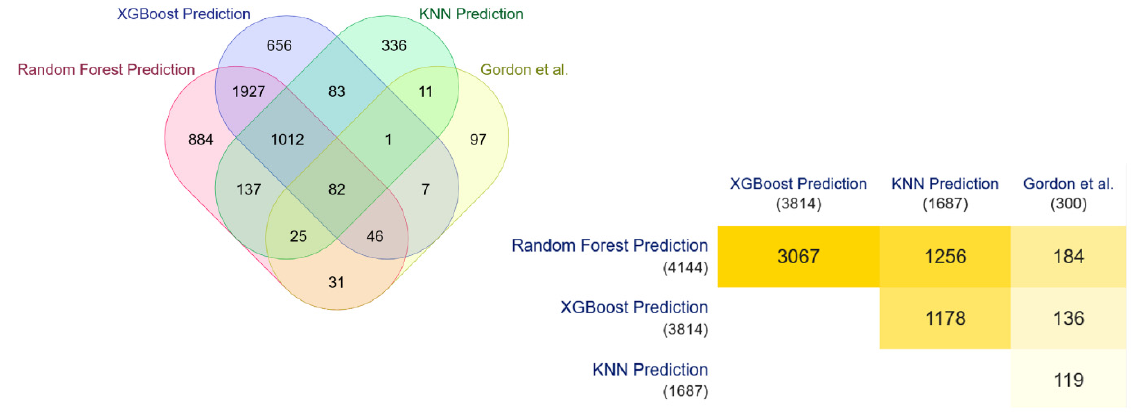
Figure 4. Overlapping of ML-DTD and Gordon et al. predicted COVID-19 human drug targets.